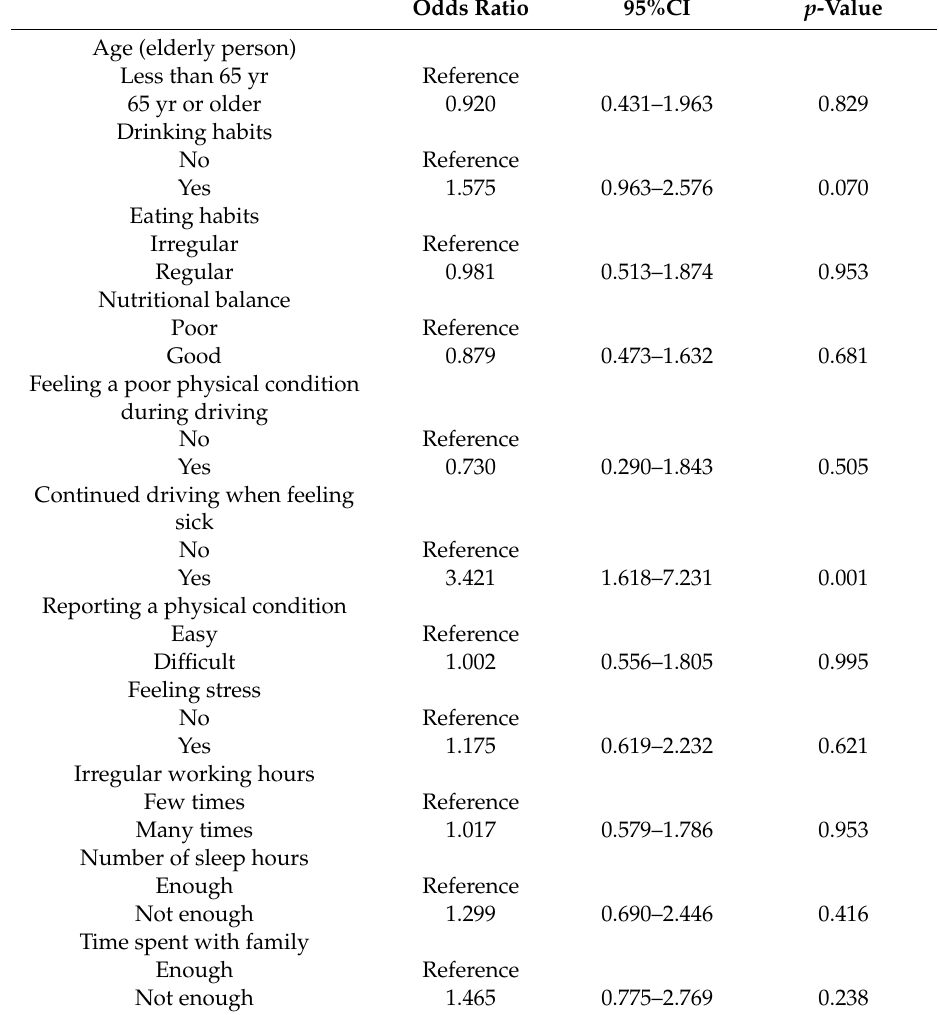
Table 3. Multivariable logistic regression analysis of risk factors for collisions and near-miss incidents related to drowsy driving (N =